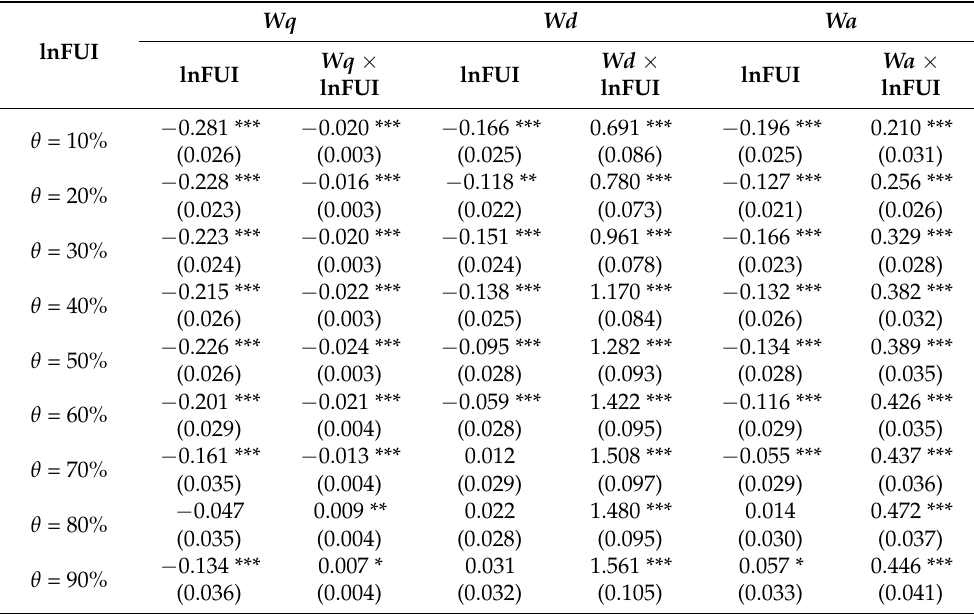
Table 6. Estimation results of QRM with the introduction of the spatial lag term.